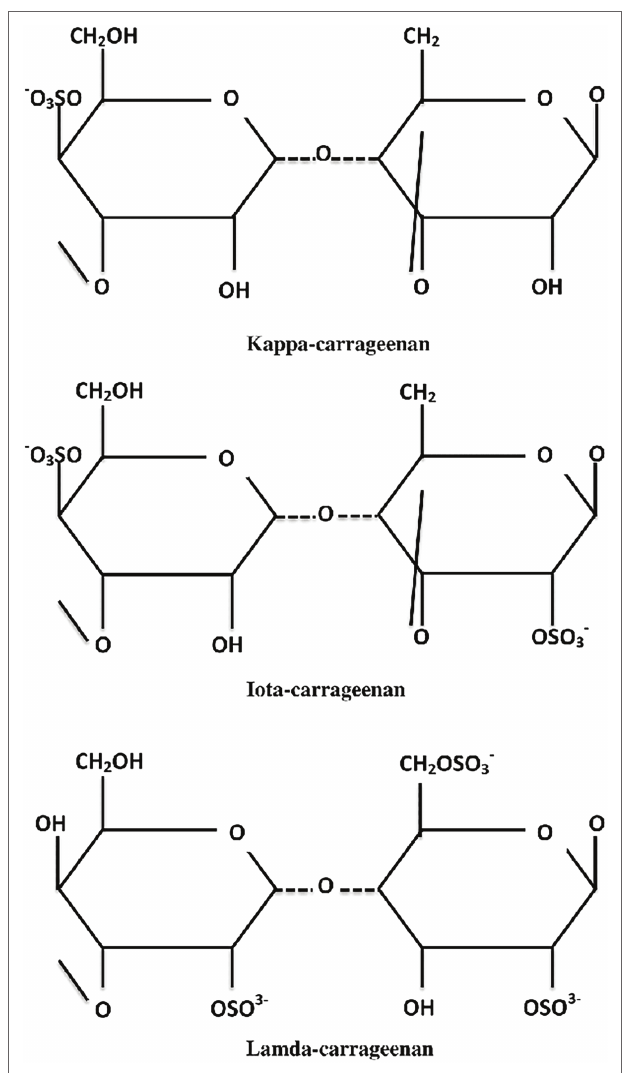
FIGURE 1 | Chemical structures of kappa ( κ )-, iota ( ι )-, and lambda ( λ )-